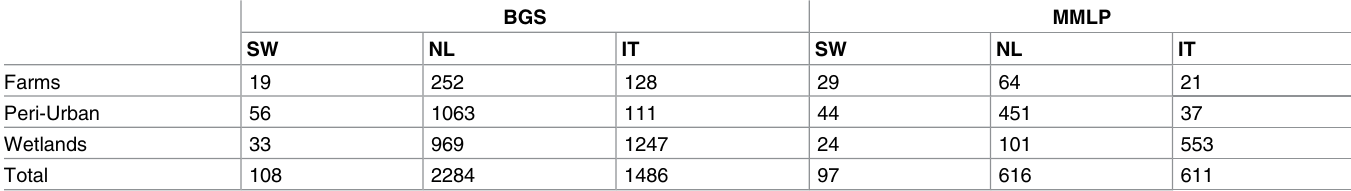
Table 2. Total number of collected Cx . pipiens females per trap type, habitat, and country. BGS = Biogents Sentineltrap, MMLP = MosquitoMagnet Liberty Plus trap, SW = Sweden, NL = The Netherlands, and IT =